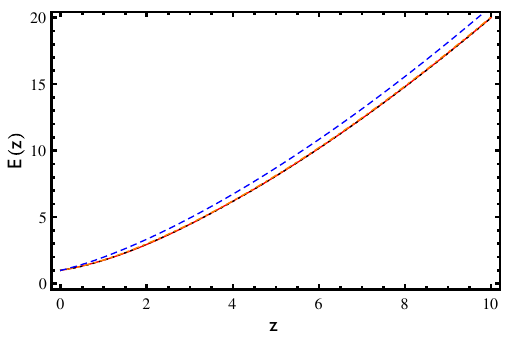
Fig. 3 The effects of the spatial curvature (cid:11) k on the dimensionless Hubble parameter E ( z ) in the VKDE model. Here we have assumed (cid:11) = 0 . 3and η = 0 . 003andthesolid(red),dotted(black),dash-dotted m (orange) and dashed (blue) lines correspond to the cases of (cid:11) k = 0 ( (cid:4) CDM), 0.003, 0.03 and 0.3, respectively